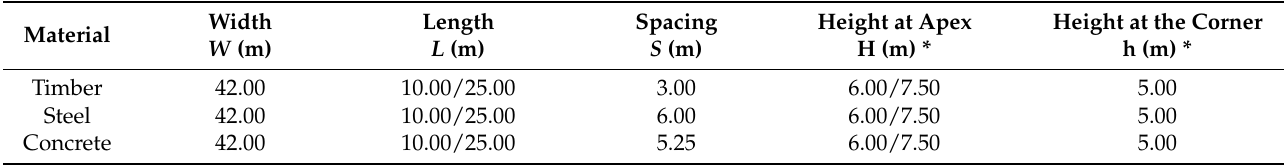
Figure 2. Illustrative drawings of connections in timber frames: ( a ) pinned column–foundation connection; ( b ) pinned apex connection; ( c ) semi-rigid beam–column connection. Table 1. Summary of the dimensions of the main